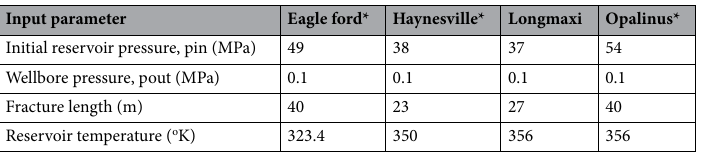
Table 2. Input parameters for selected four major shale formations 2, 12, 24–28 . *The reported values were best estimated based on